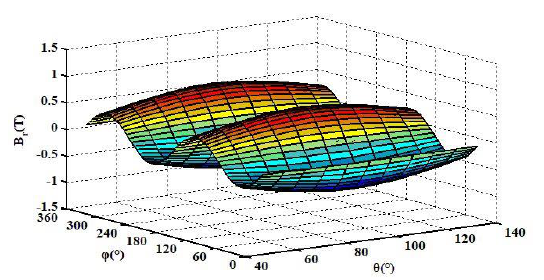
Figure 3. Three-dimensional distribution plot of B r obtained through the analytical method.